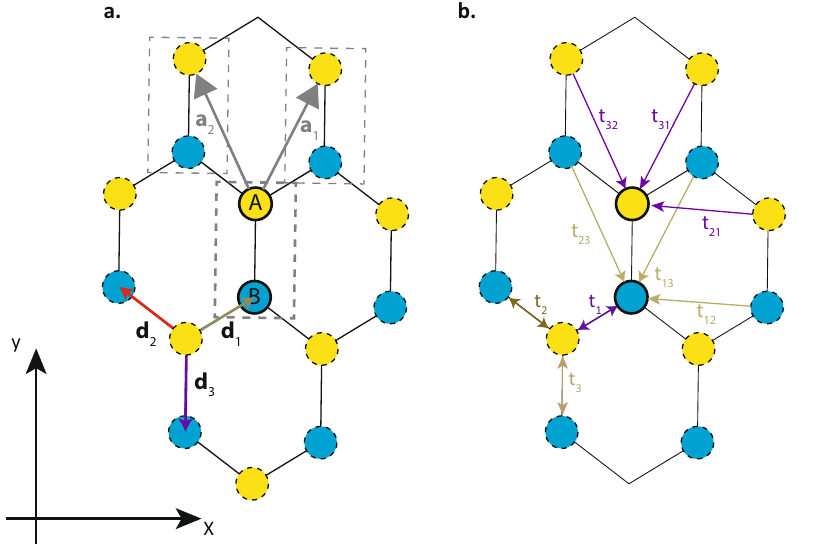
Figure 1. Schematic of a distorted silicene honeycomb lattice, lattice vectors, and inter-atomic couplings. ( a ) shows the A and B sublattice sites with bond displacement vectors d 1 , d 2 and d 3 and nearest-neighbour coupling terms. The reference repeating unit cell, denoted by thicker boundaries, is connected to neighbouring unit cells by lattice translation vectors (cid:31) a 1 and (cid:31) a 2 , which can be expressed in terms of the displacement vectors. ( b ) Schematic of the various coupling terms linking the first-neighbours and second nearest-neighbours for the lattice in ( a